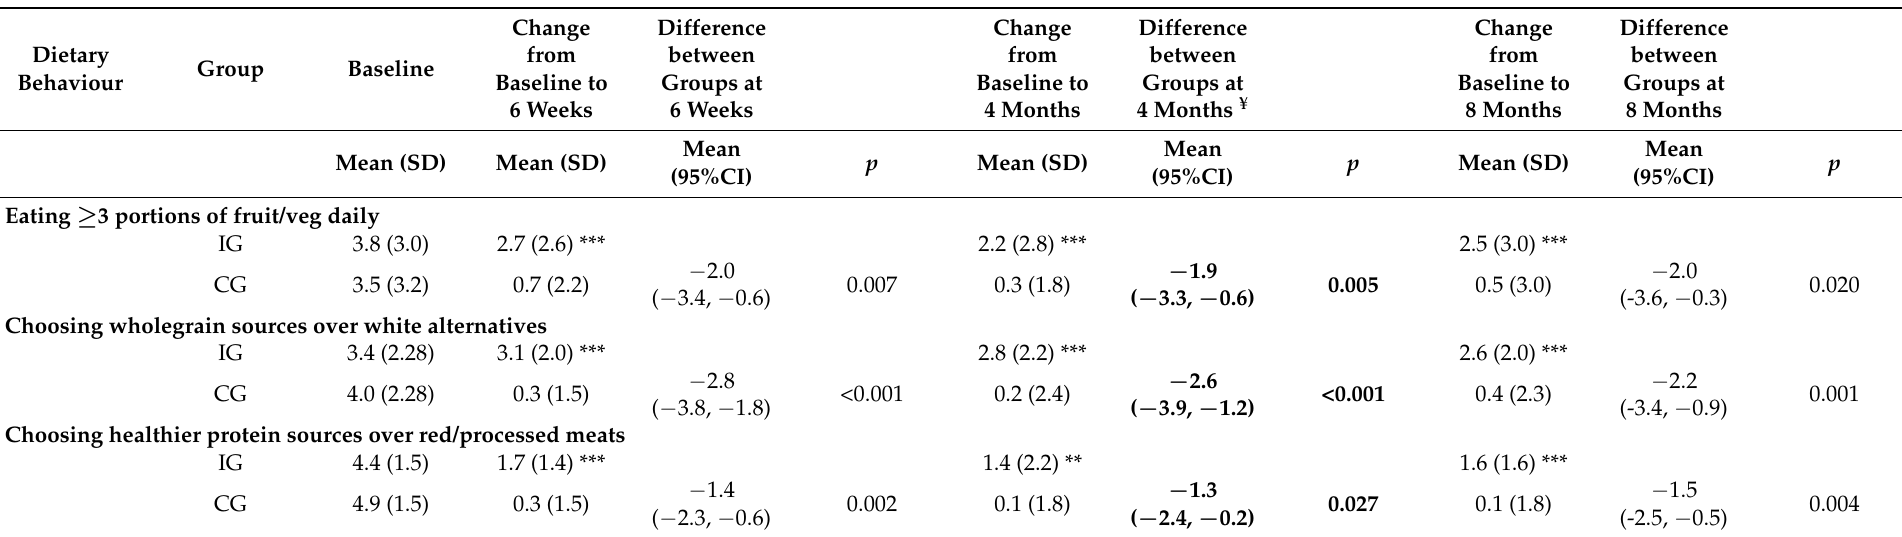
Table 4. Mean change in generic automaticity scores for three dietary behaviours by randomisation group.